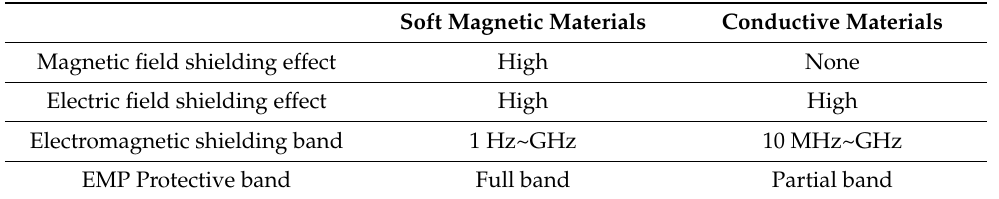
Table 1. Comparison of magnetic and electric field shielding effect between soft magnetic materials and conductive materials.